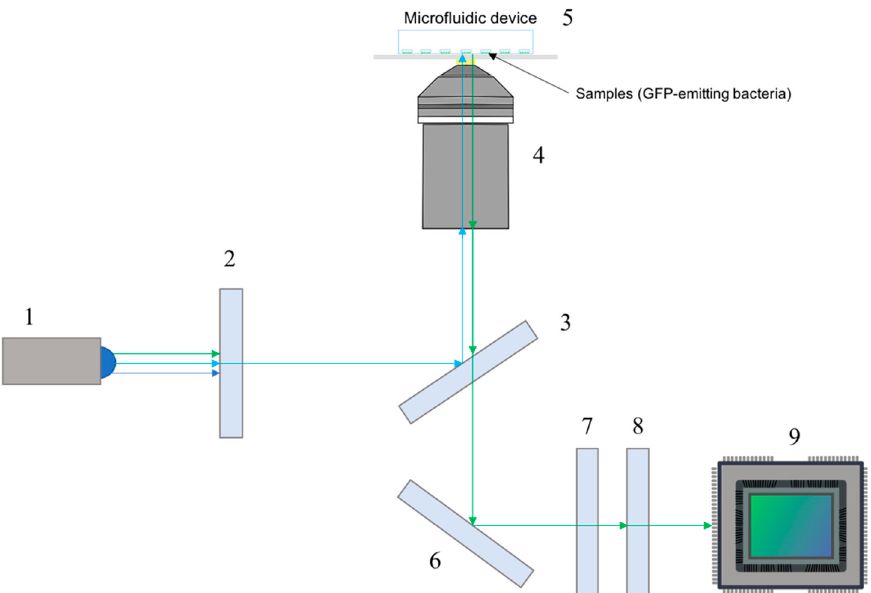
Figure 2. Schematic of the excitation and emission light paths. Components depicted are: (1) LED, (2) excitation filter, (3) dichroic mirror, (4) objective, (5) microfluidic device, (6) dielectric mirror, (7) emission filter, (8) tube lens, (9) fluorescence digital sensor.